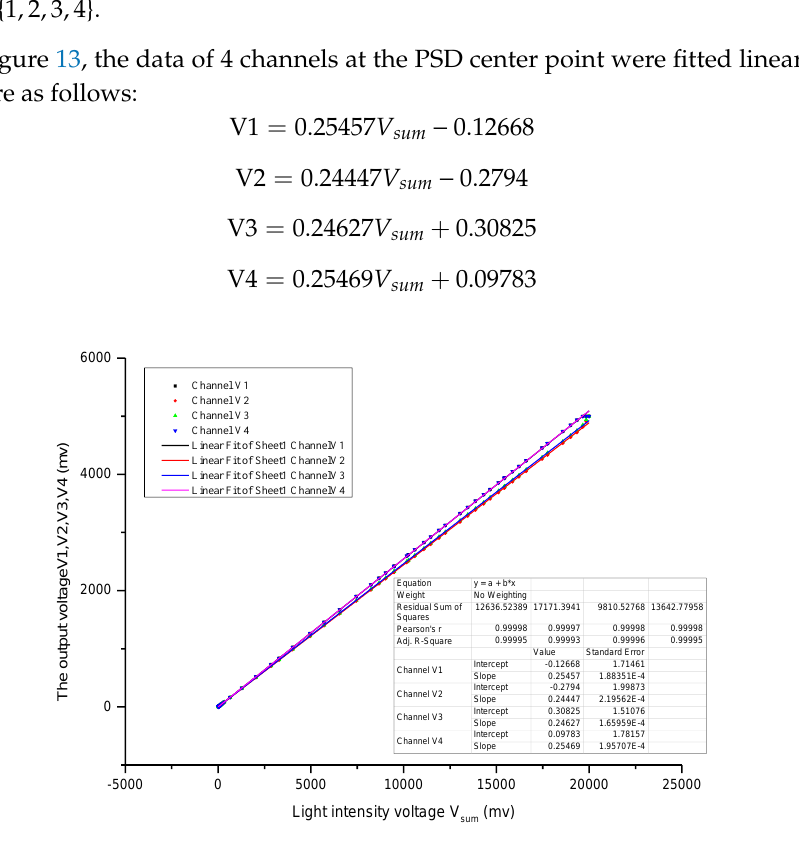
Figure 12. Calibration point coordinates with static voltage deduction.